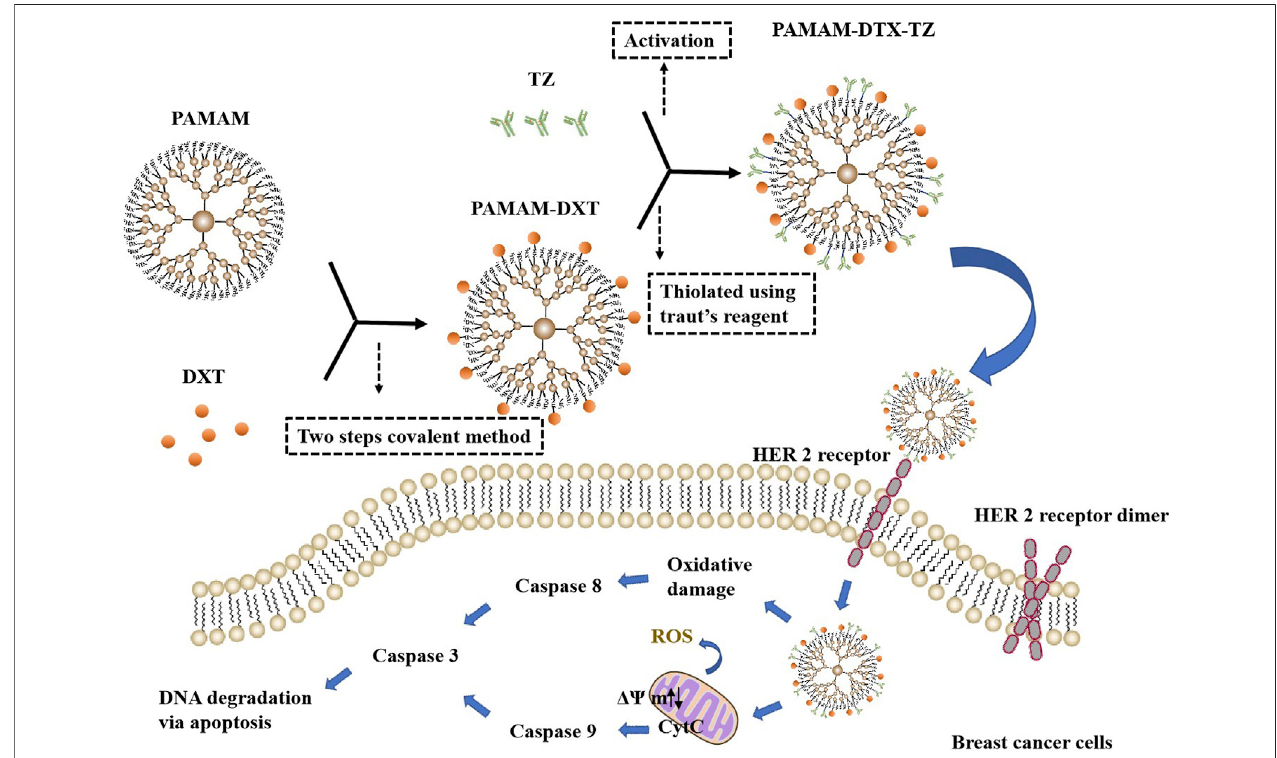
FIGURE 10 | The synthesis of PAMAM-DTX-TZ and three main modes of action. The linking of DTX to PAMAM dendrimers was done using a two-steps covalent method. Then, PAMAM-DTX thiolated using Traut ’ s reagent reacted with activated TZ to synthesize PAMAM-DTX-TZ. PAMAM-DTX-TZ showed the different potential mechanisms of cytotoxic action for breast cancer cells. The mechanism is not only associated with the blocking of the HER 2 receptor but also achieved through ROS generation (oxidative damage → caspases 8 → caspases 3 → DNA degradation via apoptosis) or changes in mitochondrial membrane potential (mitochondria damage → CytC → caspases 9 → caspases 3 → DNA degradation via